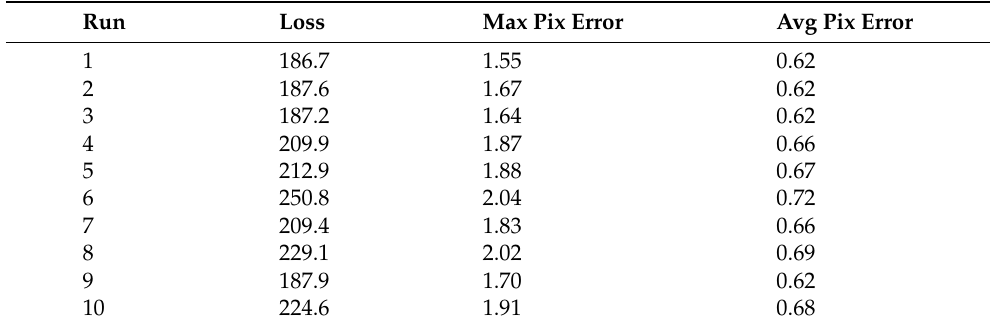
Figure 24. Detected points. Table 11. PSO real results.